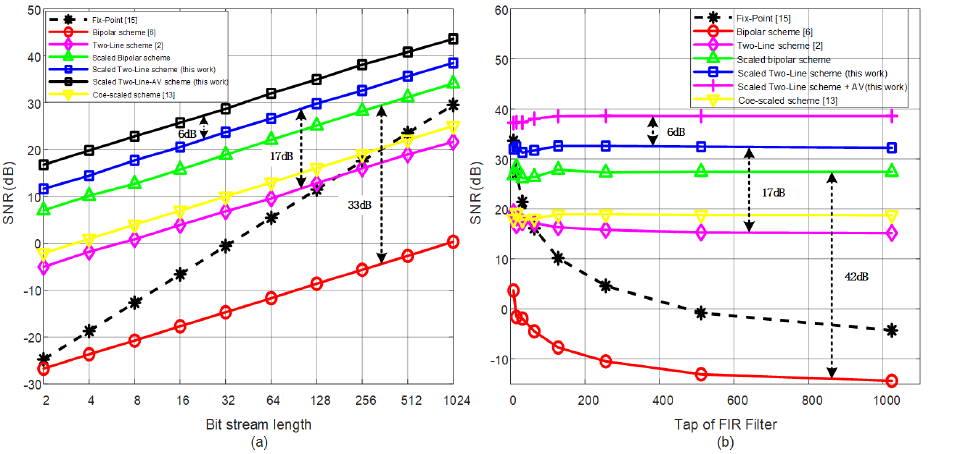
Figure 11. SNR performance evaluation on: ( a ) different bit stream lengths; ( b ) different filter